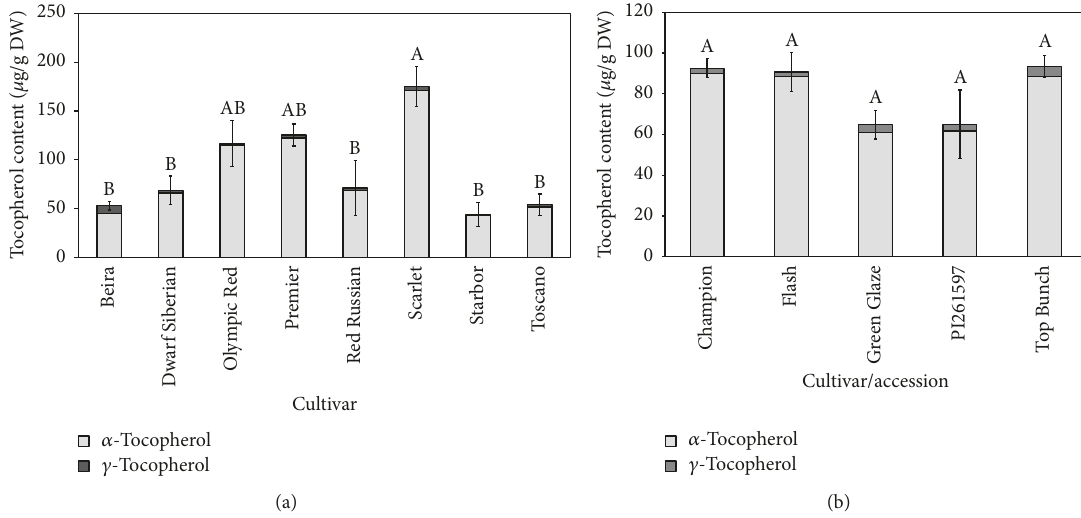
Figure 2: Tocopherol (vitamin E) content in kale (a) and collard (b). Light grey bars, 𝛼 -tocopherol; dark grey bars, 𝛾 -tocopherol. Data are shown as mean ± standard error for the total vitamin E content ( 𝑛 = 3 ). Total vitamin E content in collard was not different among cultivars of kale. Different letters for kale mean significant difference in the total vitamin E content among cultivars by Tukey’s HSD at p ≤ 0.05.